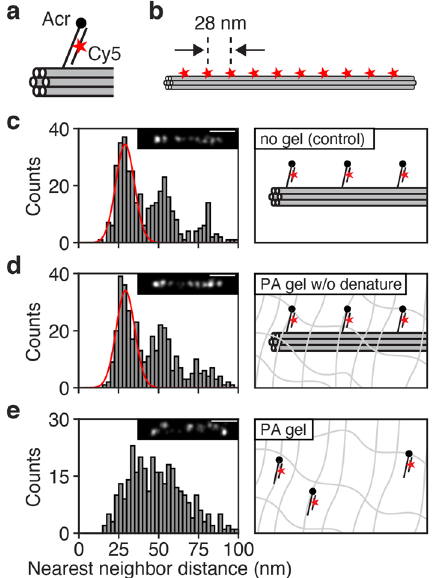
Figure 1. PA gel embedding does not preserve sub-30 nm structure. ( a ) DNA origami labeling strategy: Selected staple strands contain an acrydite group for PA gel anchoring and can later be fluorescently labeled through hybridization of a secondary oligo featuring an internal Cy5 dye. ( b ) Linear DNA origami design featuring 10 labeling sites spaced 28 nm apart. ( c–e ) STORM image analysis for linear origami ( c ) without gel (N = 100 origami objects), ( d ) post-embedding in a PA gel without denaturation (N = 100 origami objects), and ( e ) post-embedding in a PA gel (N = 98 origami objects). Insets show representative STORM images of single origami objects. The scale bars in the insets are 100 nm. Histograms show nearest neighbor emitter distances within origami objects. Red curves show Gaussian fits of the first peaks, mean ± standard deviation: ( c ) 29.1 ± 8.3 nm and ( d ) 29.4 ± 8.3